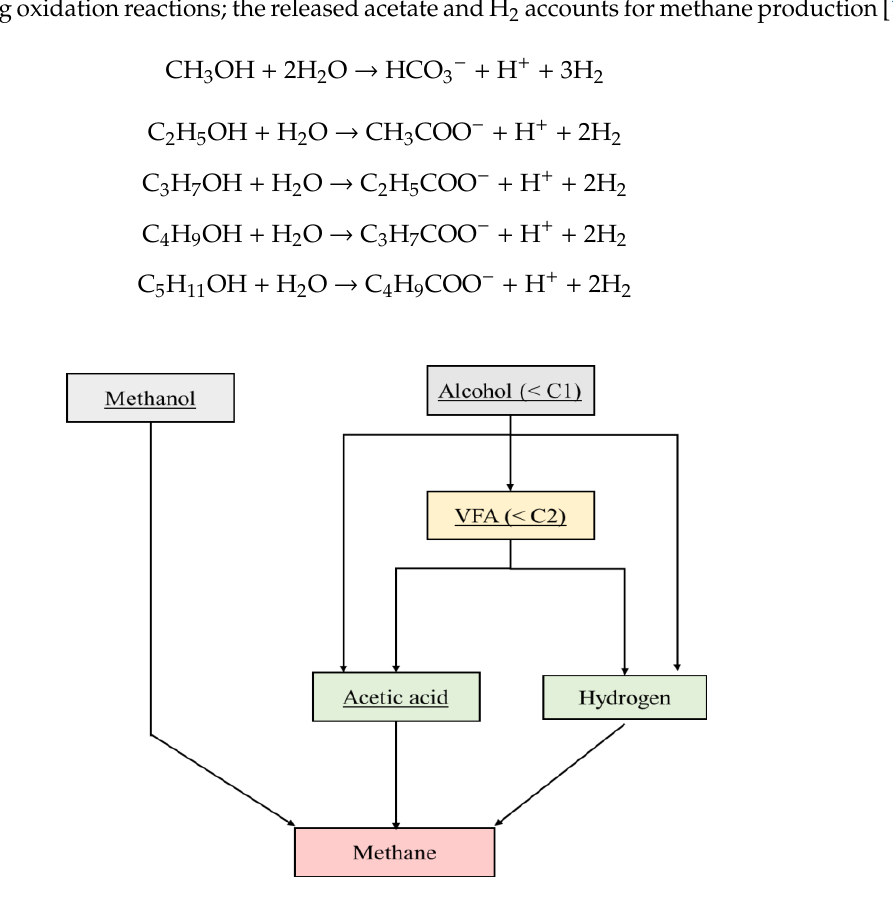
Figure 3. pathway of the anaerobic conversion of alcohol to methane[113].